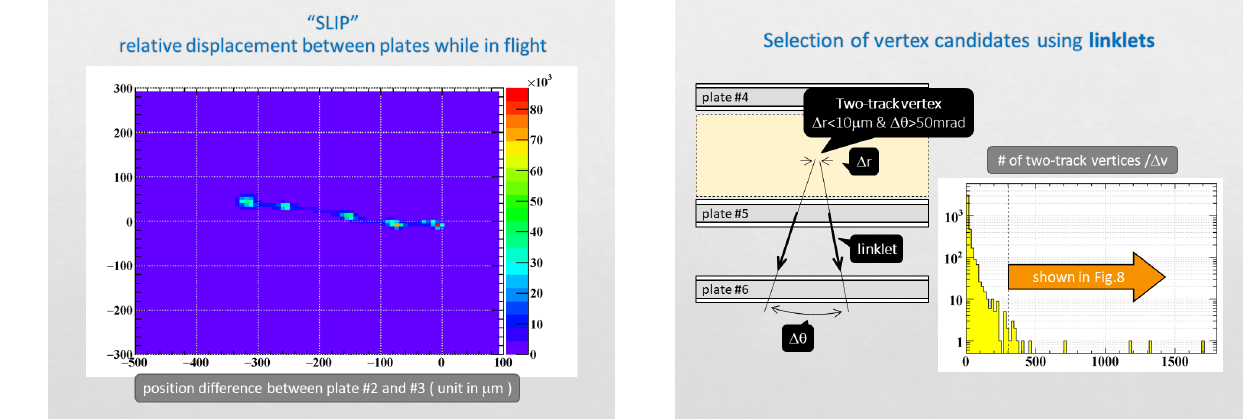
Fig 3. A schematic picture of a cosmic ray interaction occurring and recorded in an emulsion chamber. Fig 6. An example of base-track recognition e ffi ciency for plate #5 in zone = 5, which is that it depends on plate quality and is not quite uniform.